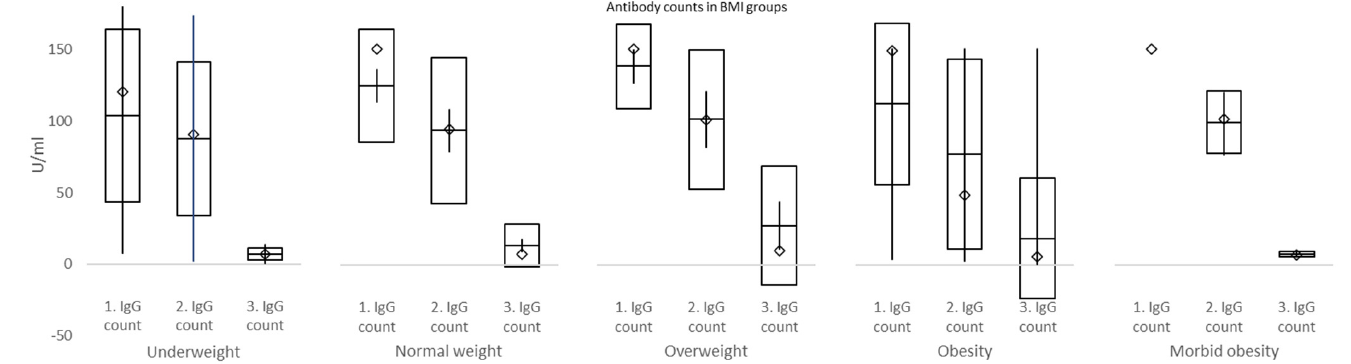
Figure 6. Difference of IgG counts between body mass index (BMI) groups (in underweight, normal weight, overweight, obesity, and morbid obesity subgroups were 4, 48, 27, 12, and 3 subjects, re- spectively) □ mean ± standard deviation; ◊ median; │ minimum − maximum.